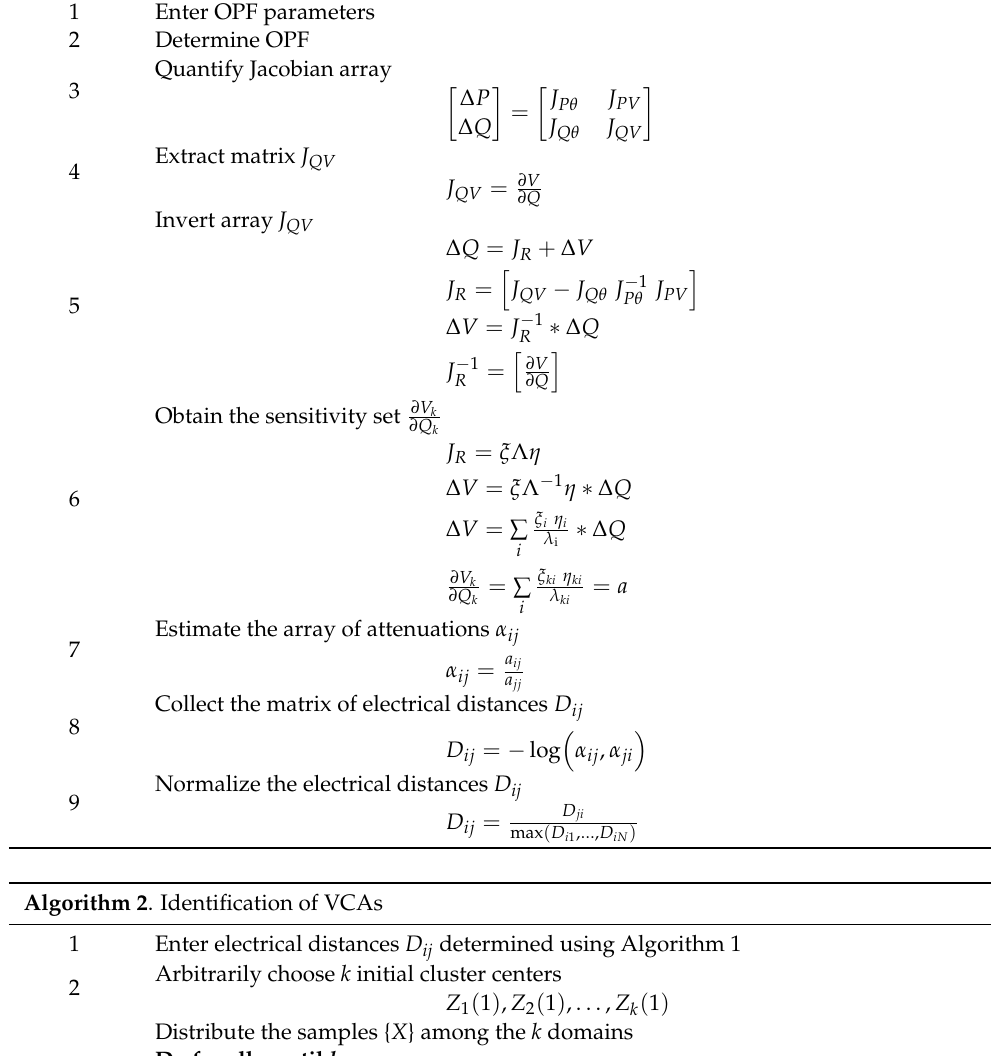
Algorithm 1 . Procedure for the creation of VCAs